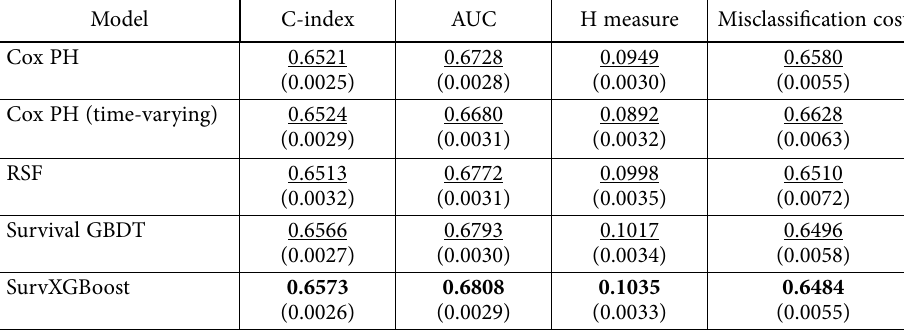
Table 5. Performance of SurvXGBoost and the benchmark models